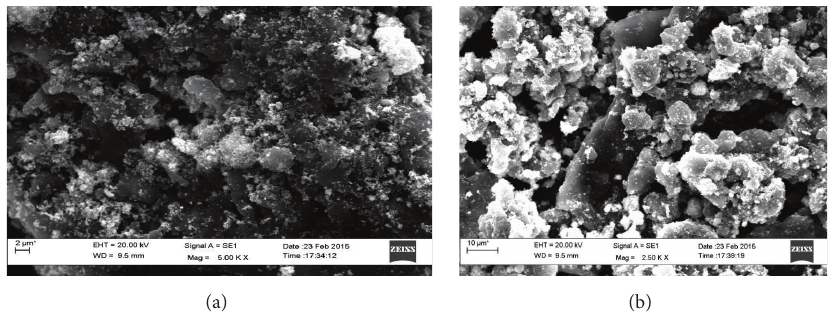
Figure 3: SEM images of (a) electrode without enzyme and (b) with enzyme.